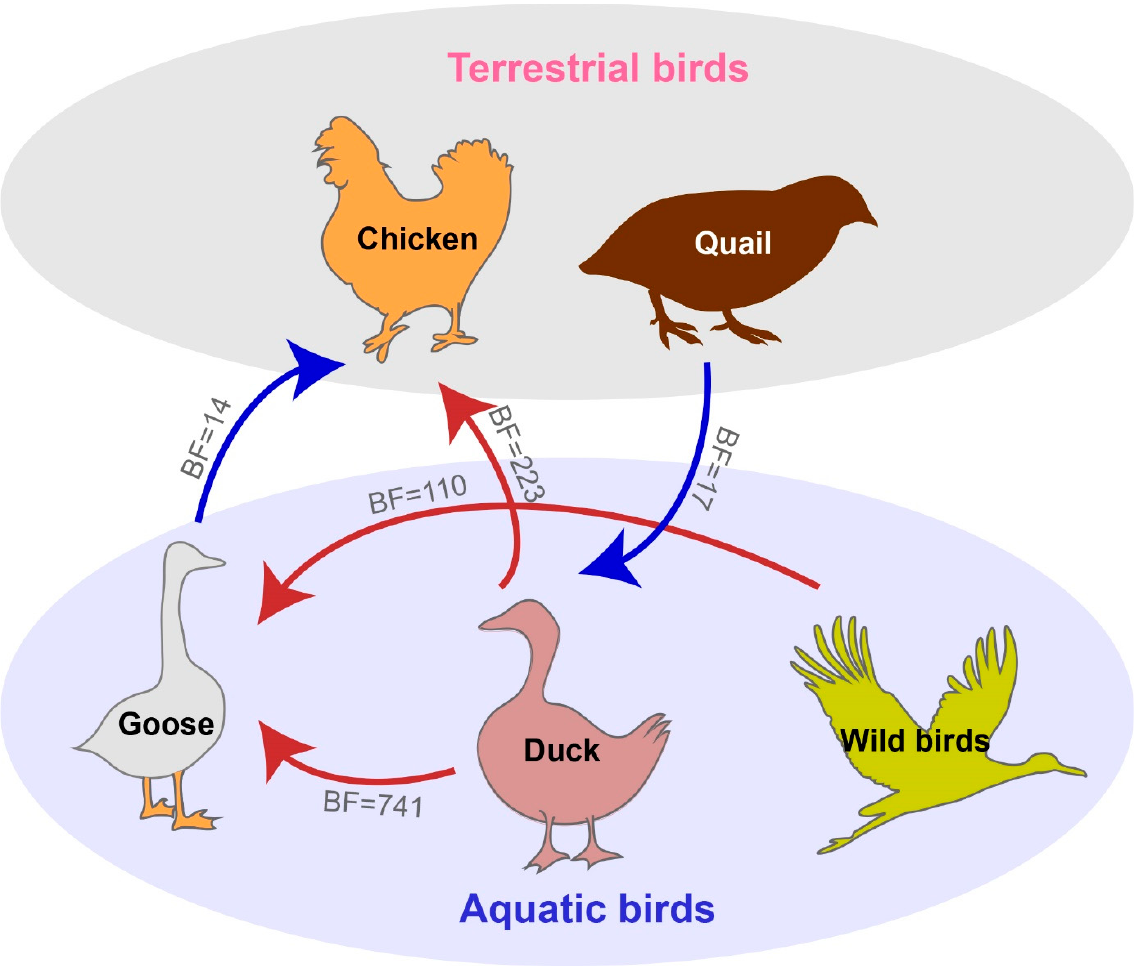
Figure 6. Host transition of H6Nx influenza viruses in China. Analyzing transition routes with Bayes factor (BF) values exceeding 10 were selected for analysis. The blue and red arrowhead represent the 10 < BF < 100 and BF > 100, respectively.